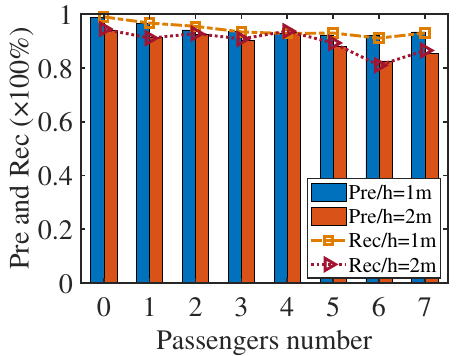
Figure 15. Performance comparison of different antenna heights.